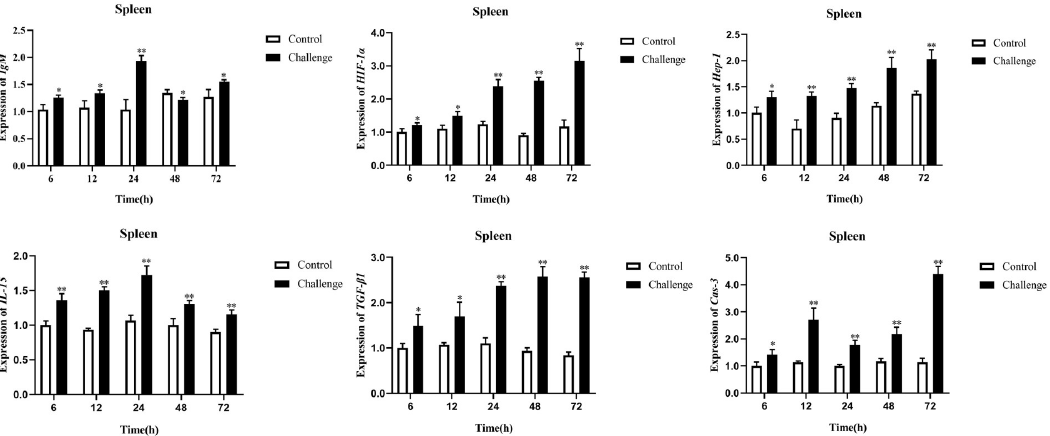
Figure 8. Expression patterns of immune related genes in spleens after A. veronii infection at different time periods. Bars represent mean ± S.E. * p < 0.05; ** p < 0.01.